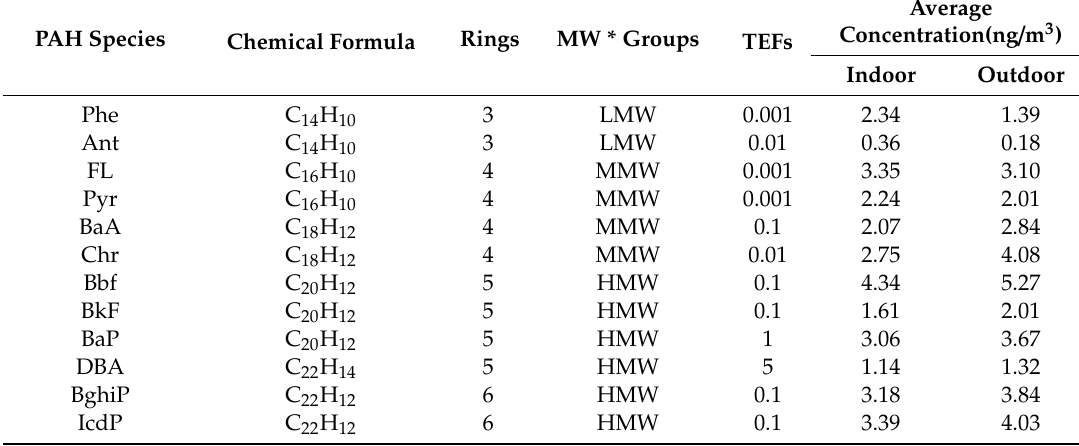
Table 2. PAH species, toxic equivalent factors (TEFs) and